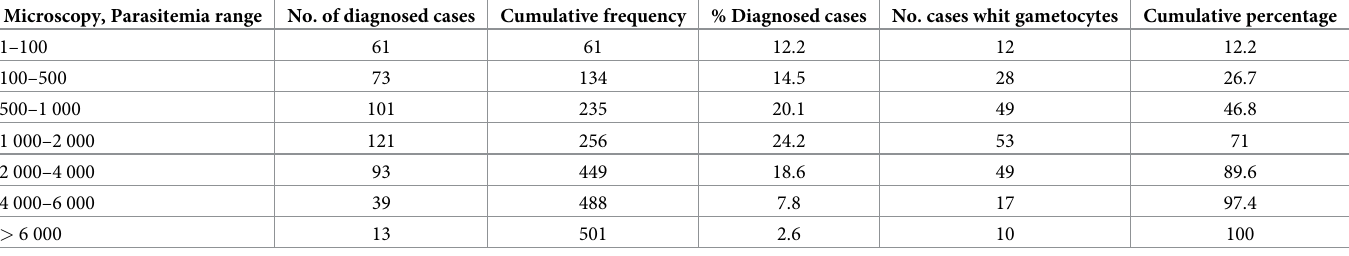
Table 5. Characterization of malaria cases according to parasitic density and presence of gametocytes, following microscopic quantification as parasites/ μ l of blood. Microscopy, Parasitemia